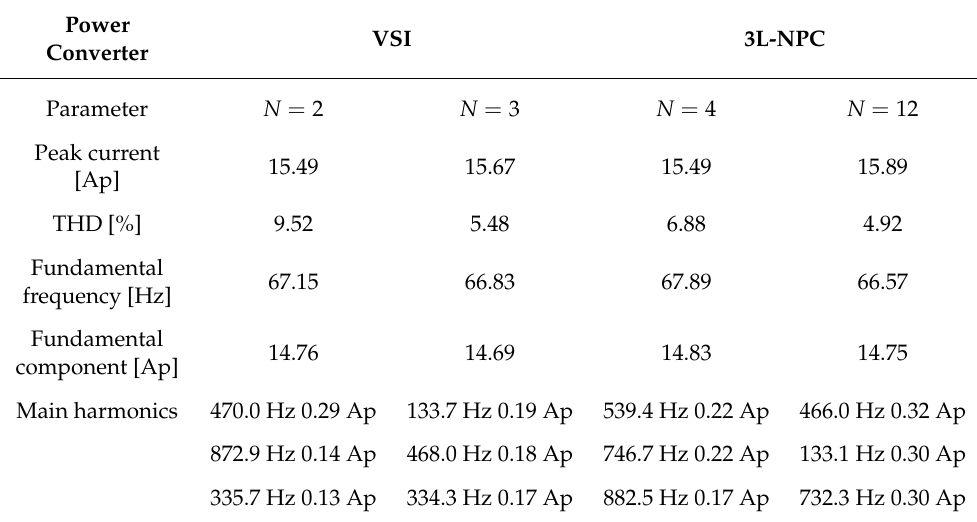
Table 2. Harmonic content analysis of the stator currents.